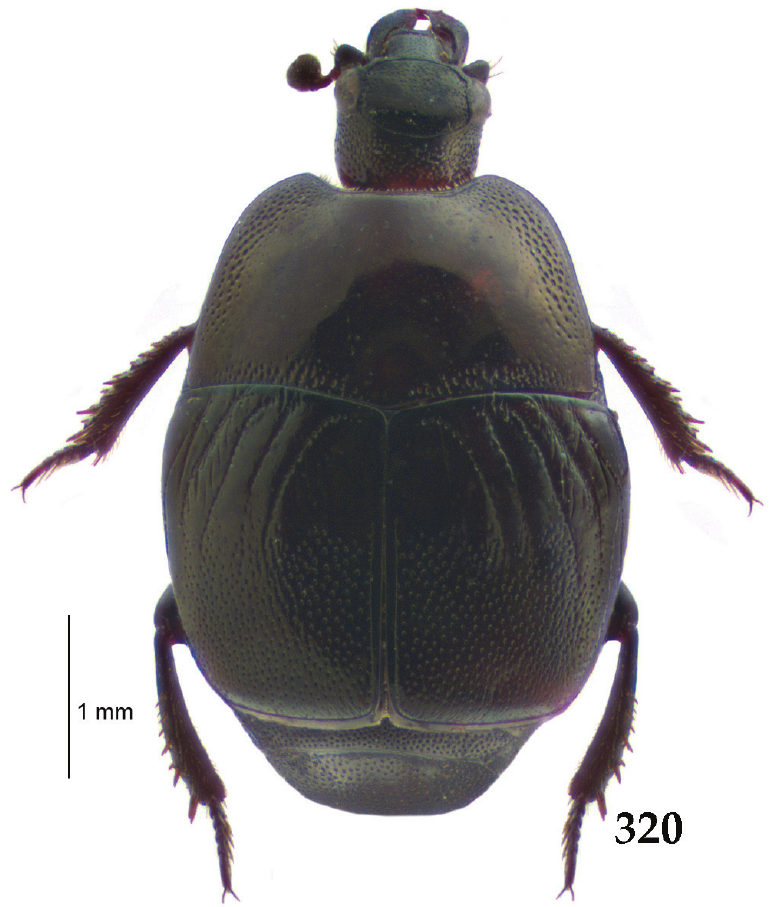
Figure 320. Saprinus ( Saprinus ) artensis Marseul, 1862 habitus, dorsal view.